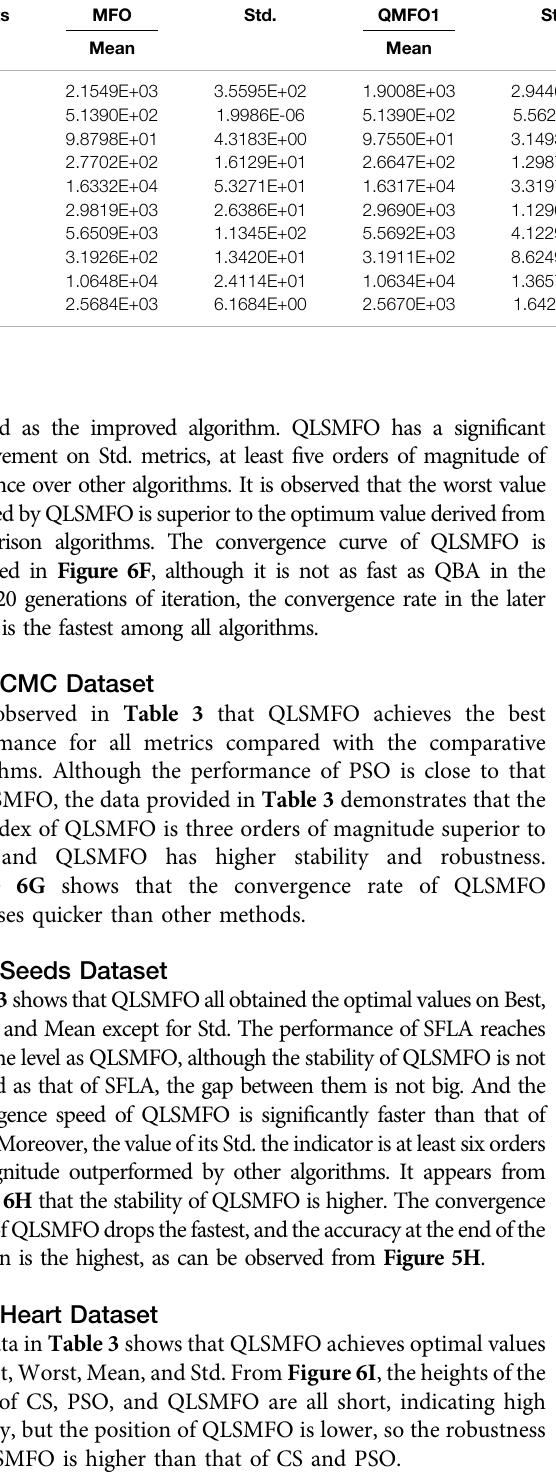
Std. from Table 3 . Best metric of ABC, ALO, CS, DE, MFO, PSO,